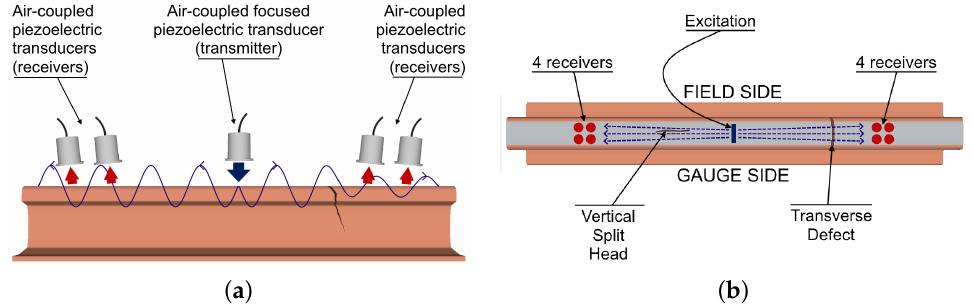
Figure 12. Schematic of the non-contact defect detection system based on ultrasonic guided waves: ( a ) side view and ( b ) top view. The two red lines indicate the possible locations of a vertical split head and a transverse defect